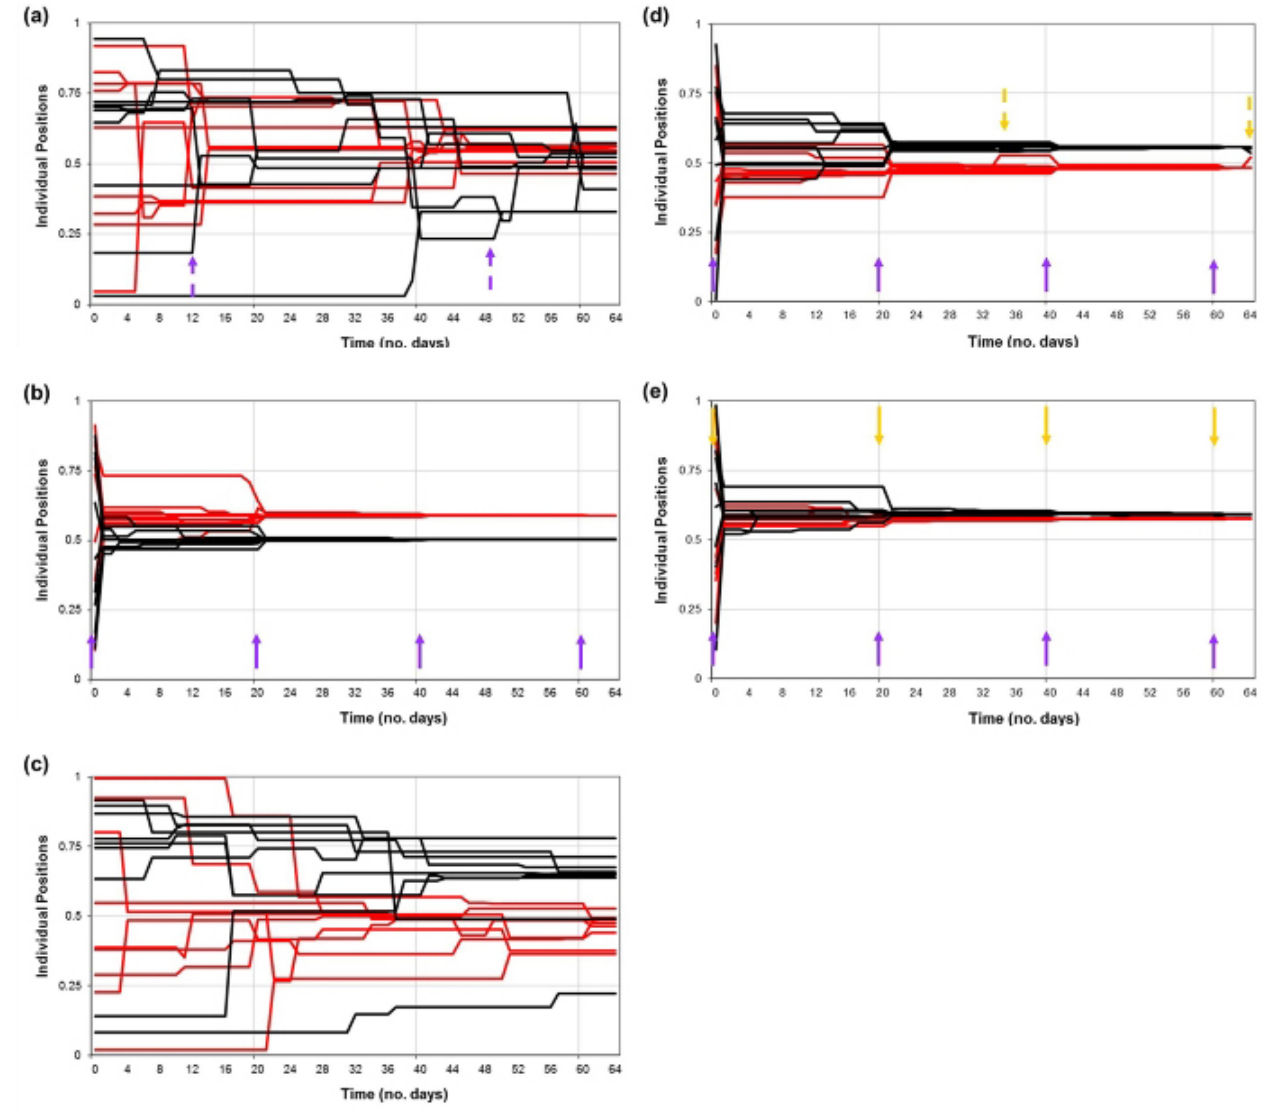
Fig. 6 . Evolution of individual positions in two groups across interaction type scenarios: (a) Scenario 1, (b) Scenario 2, (c) Scenario 3, (d) Scenario 4, and (e) Scenario 5. Yellow arrows indicate intergroup interactions and purple arrows indicate intragroup interactions. Solid arrows show formal interactions and dashed arrows show informal interactions. (Note: only a few examples of informal meetings are